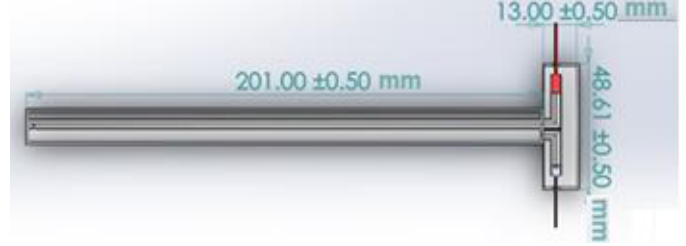
Figure 4. The design of the transducer utilizing Solidwork.